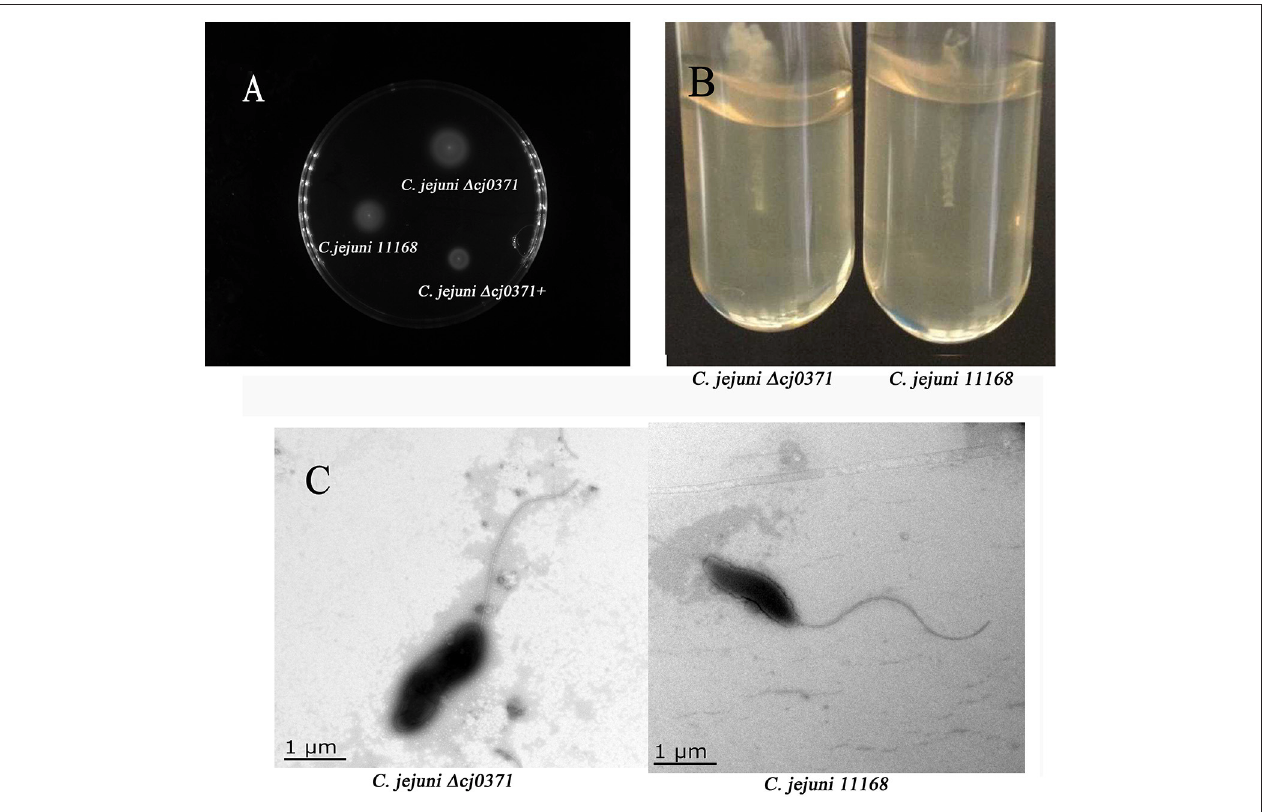
FIGURE 4 | Motility plate assay and TEM imaging. (A) Motility analysis of C. jejuni 11168, the cj0371 mutant and the complemented strain on soft agar. WT, wild type C. jejuni 11168-, C. jejuni 1 cj0371 +, C. jejuni 1 cj0371 +. (B) C. jejuni 11168 and C. jejuni 1 cj0371 were cultured in a soft agar tube for 48h to analyze motility.